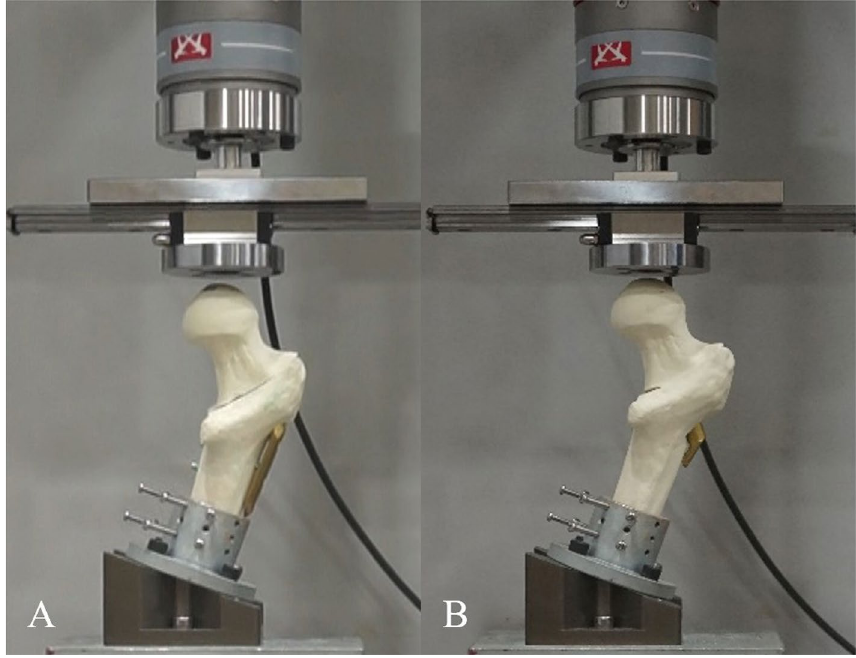
Figure 4. Test setup with a femur specimen instrumentation with ( a ) FNS and ( b ) DHS